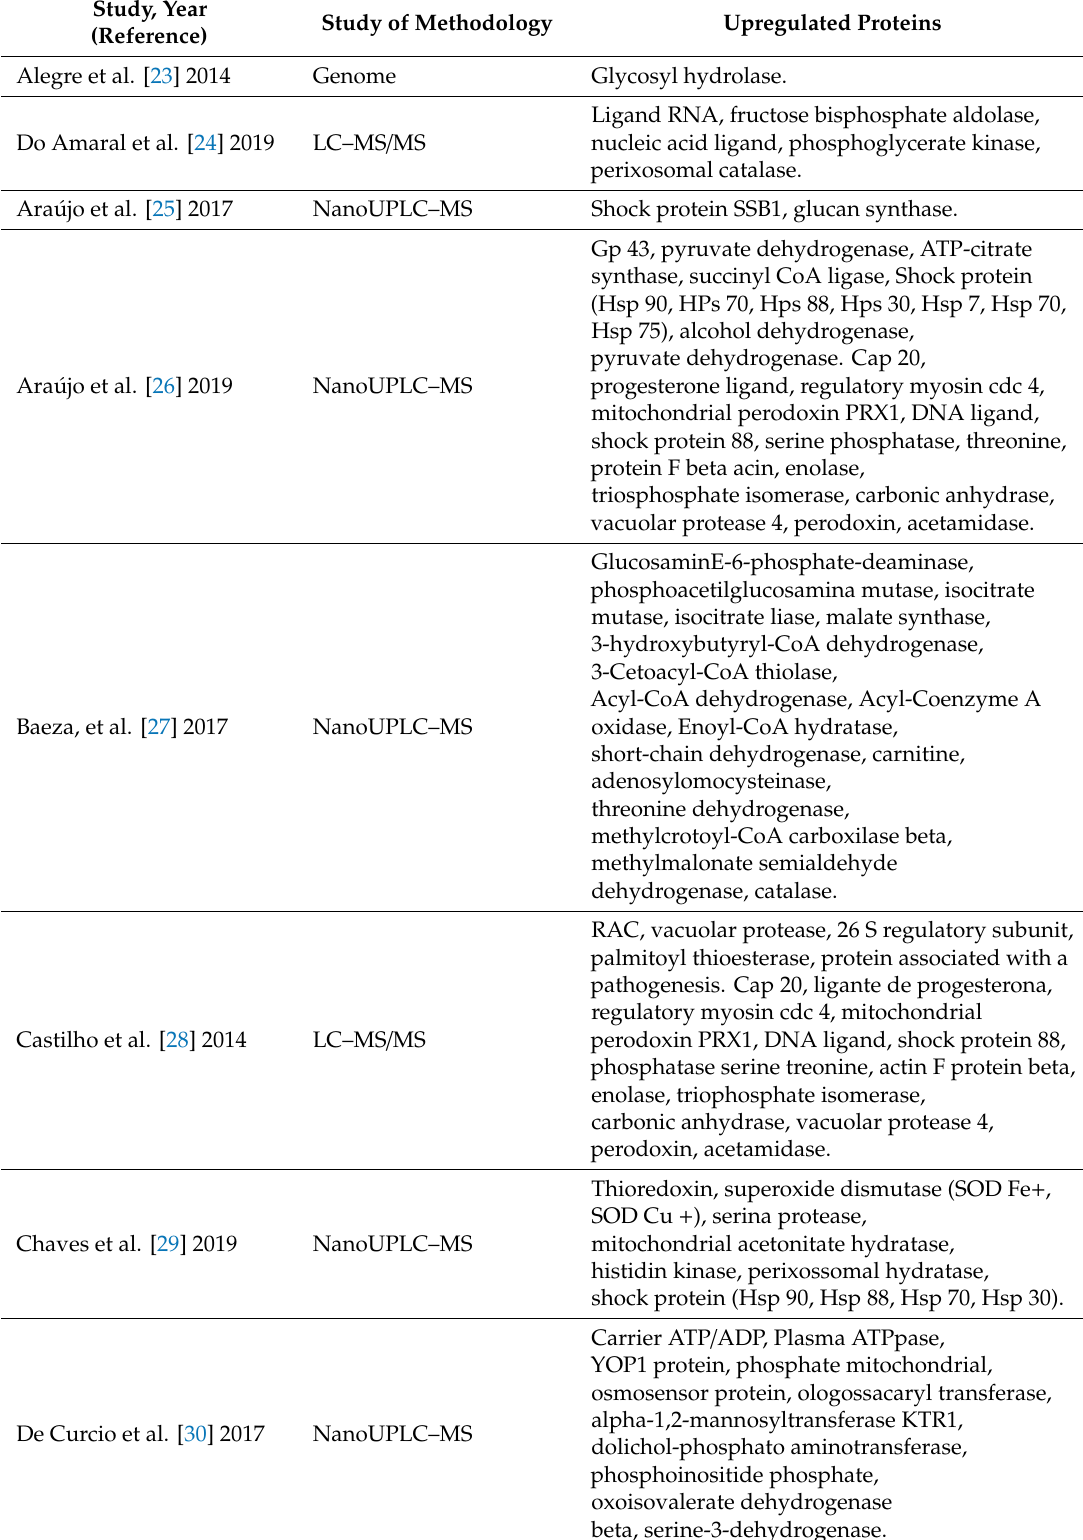
Table 1. Papers selected in the rapid